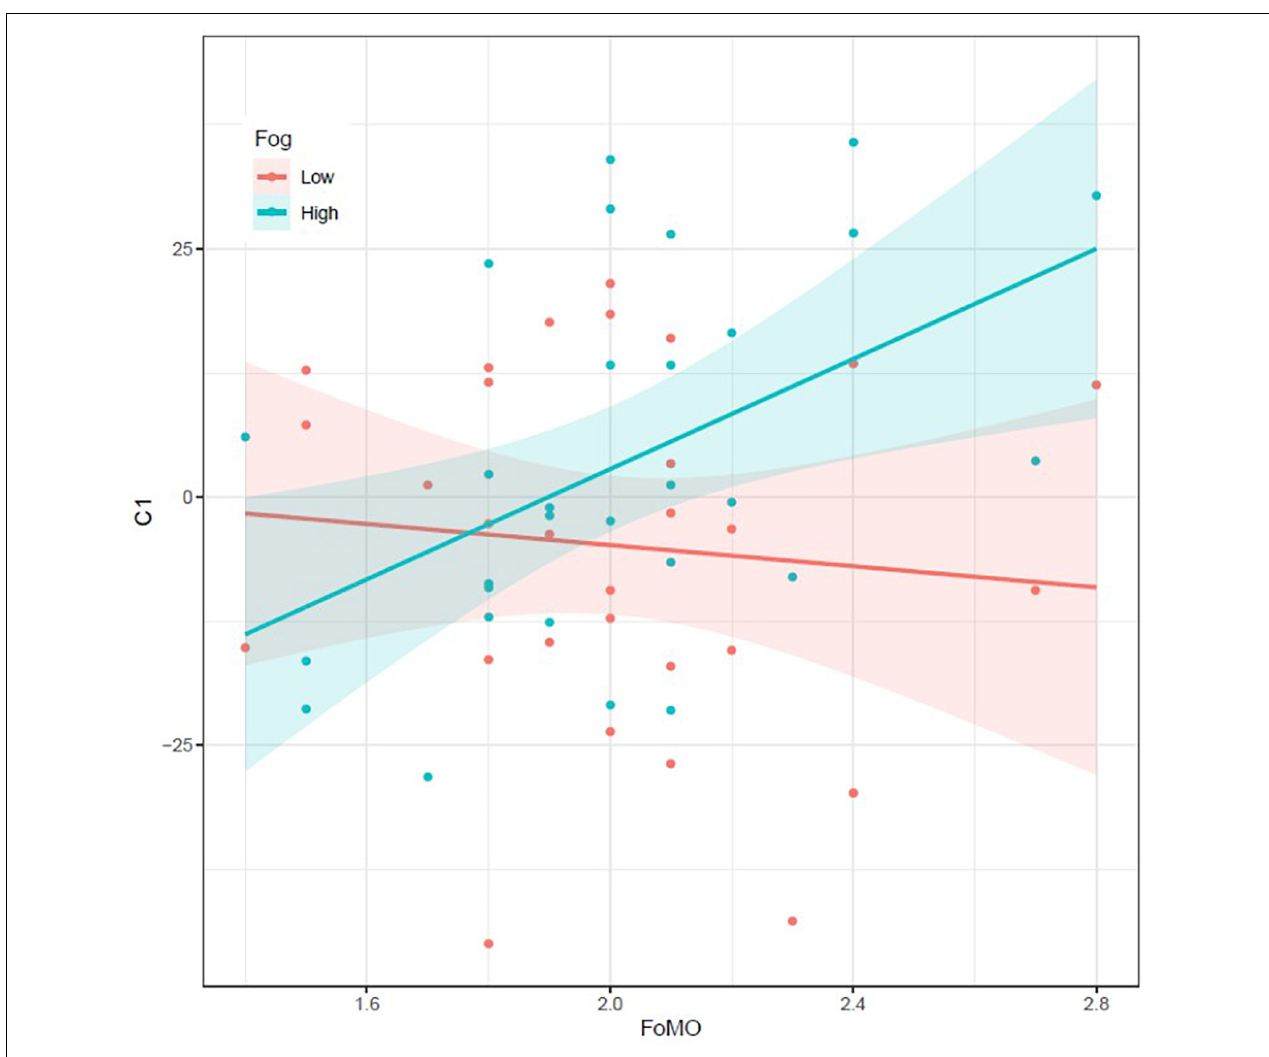
FIGURE 3 | Distraction effect (in ms; with standard error bands) triggered by the high vs. low/no social reward distractor (contrast code C1) under low (red line) and high (green line) fog density for each participant, as a function of Fear of Missing Out (FoMO) scores.